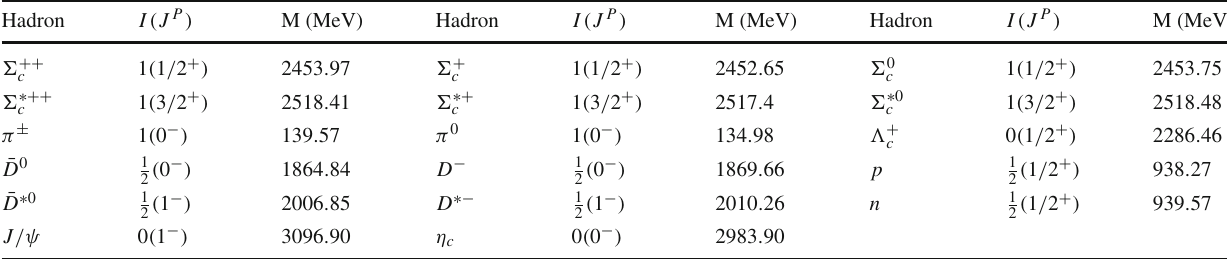
Table 1 Masses and quantum numbers of relevant hadrons used in this work [73]